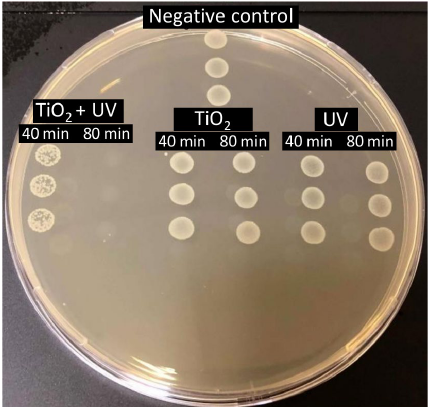
Fig. 4 The ability of S. enterica cells to form colonies determined by DP method. Obtained results after overnight incubation at 37